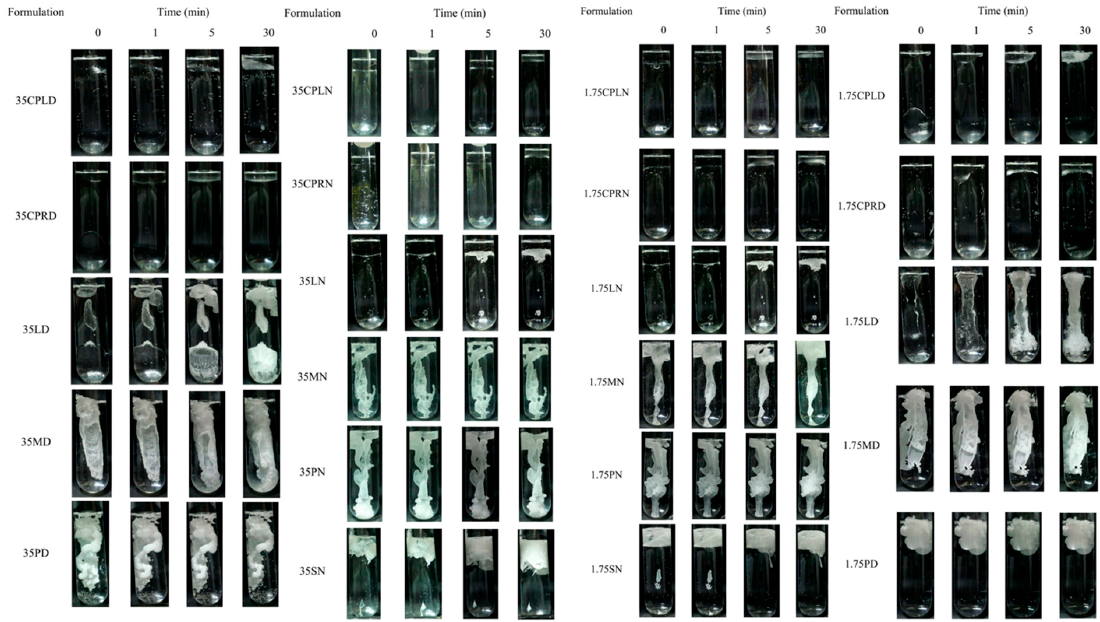
Figure 1. In vitro matrix formation behavior of fatty acid-based in situ forming matrix in PB with pH 7.4 (triplicate testing; n =